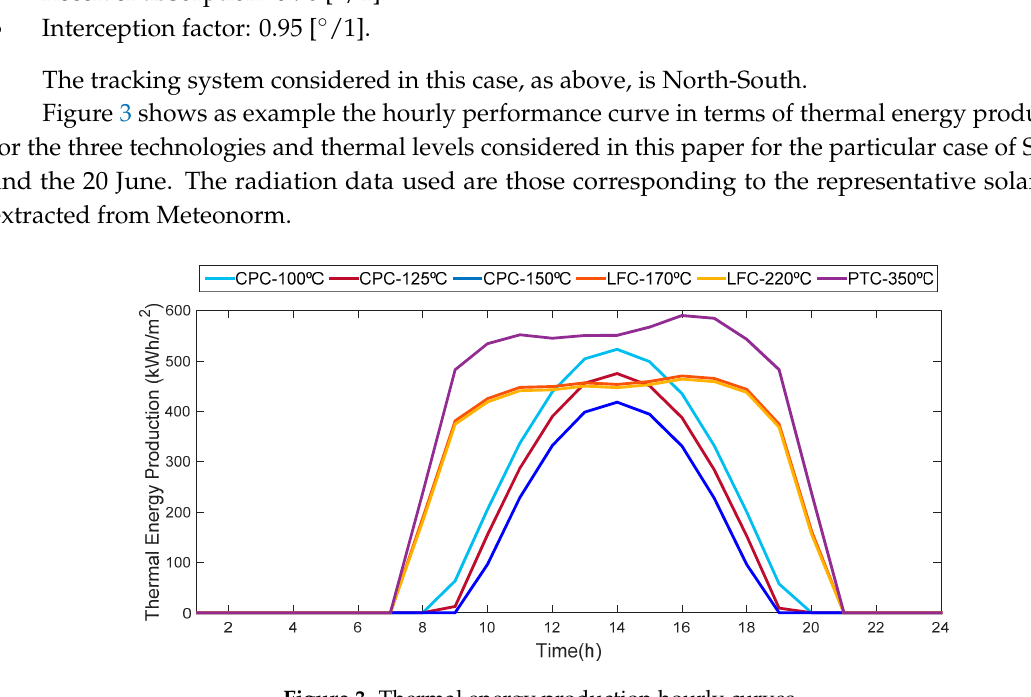
Figure 3. Thermal energy production hourly curves.